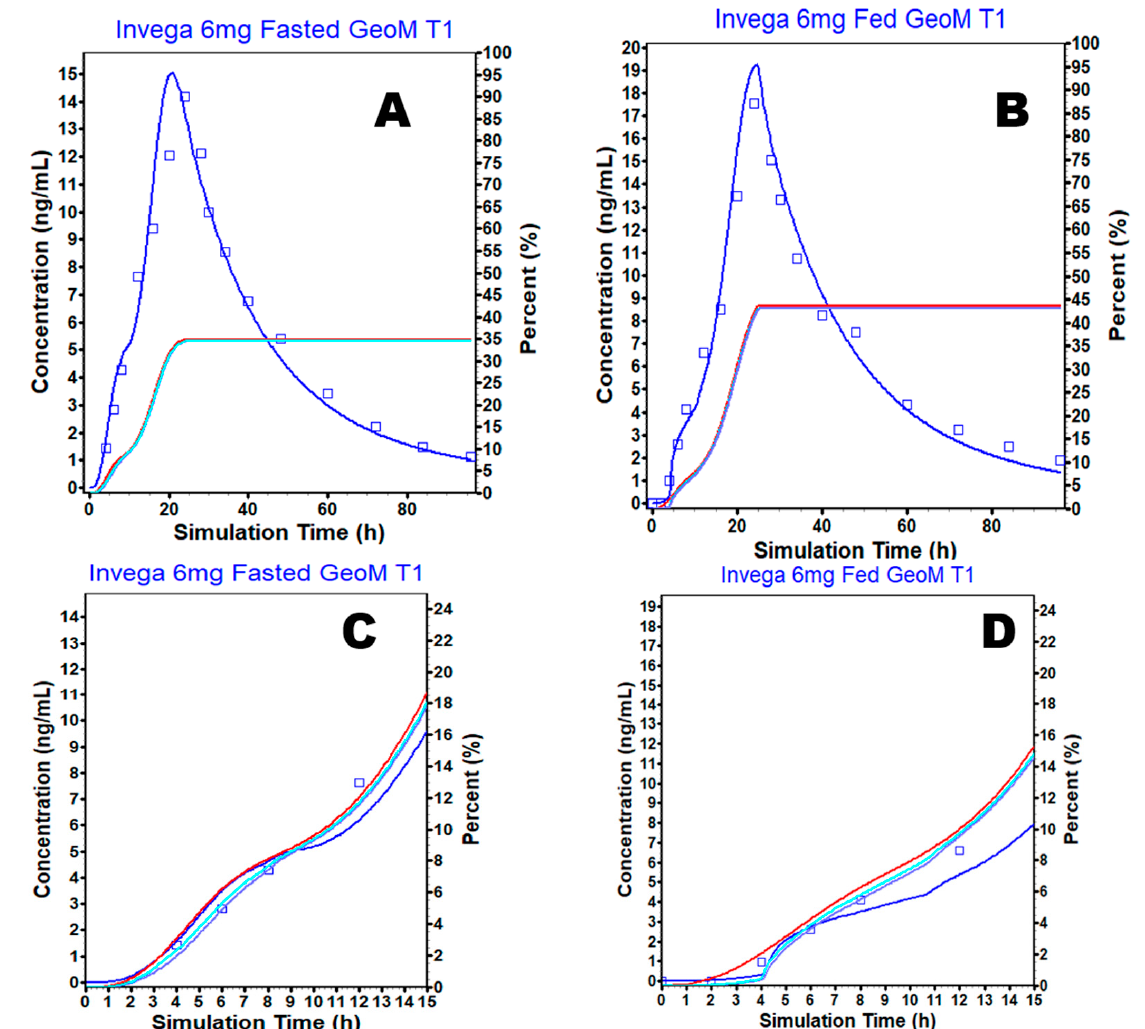
Figure 4. Predicted versus observed plasma concentrations over time using the final model after the oral administration of PAL ER OROS tablet in ( A ) fasted and ( B ) fed (blue solid line—predicted plasma concentration, blue square box with bars—observed mean plasma concentration, red solid line—amount dissolved, purple solid line—amount to the portal vein, light blue solid line—amount absorbed). ( C , D ) are the same than A and B but with time truncated at 15 h to increase the resolution of the initial times.